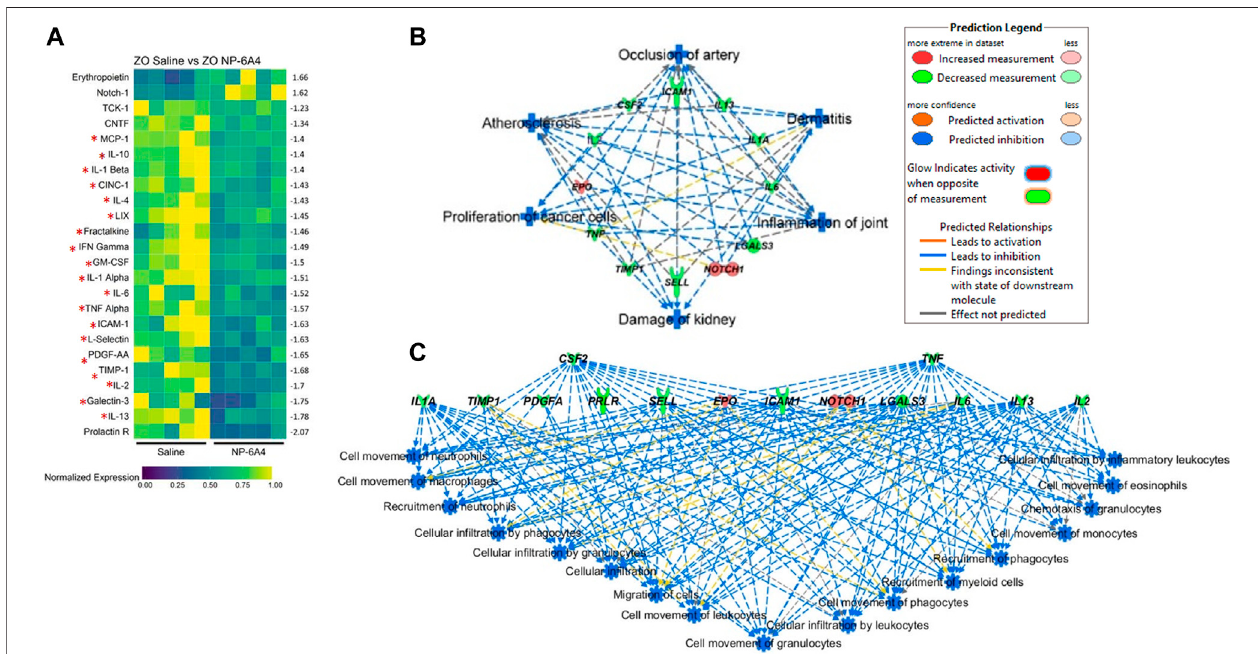
FIGURE5| NP-6A4suppressed alarge arrayofin fl ammatory and fi brotic cytokines implicated inboth cardiac pathologies and cytokine storm and simultaneously increasedexpressionofcardio-protectiveerythropoietin(EPO)andNotch1thatpromotemyocardialrepairinthehearttissuesofobeseandpre-diabeticZOrat. (A) Heat map shows agraphic representation of relative expression of 24differentially expressed intracardiac cytokines signi fi cantly different between saline and NP-6A4 treated ZO rat hearts. Individual cardiac samples are arranged along the x -axis and cytokines along the y -axis. 19 cardiac molecules implicated in cardiac pathologies ( Table 1 ) and suppressed by NP-6A4 are marked by red star. Fifteen cytokines that exhibited 1.5-fold differential expression in either direction were further selected for IPA analysis (see Supplementary Table S3 ). n (cid:1) 5 animals per group. Yellow indicates the highest expression for each cytokine (1.0), while dark blue indicates lower expression relative to the sample with the highest expression. Expression was normalized for each cytokine across all animals (across each row). Statistical signi fi cance was determined using Student ’ s t-test. p < 0.05 for all proteins. (B) Top scoring IPA-predicted diseases and functions networks resulting from the comparison of cytokineproteins( SupplementaryTableS3 )ofsalineandNP-6A4 treatedZOrathearts.Sixdiseasesandfunctionswerepredictedtobesuppressed(blueincolor)by NP-6A4 treatmentbasedon thiscytokinepro fi le.Additional details foreach individualnetworkinthisgroup areprovided in SupplementaryFigureS2 . (C) Immune cell speci fi c functions that are predicted to be suppressed in NP-6A4 treated ZO rat hearts. Green cytokines indicate downregulation in NP-6A4-treated compared with saline-treated ZO rat hearts. The blue connecting lines show a known relationship between the cytokine and the cellular process/function. This fi gure was generated using IPA ’ s built in feature for “ Diseases and Functions ” , and then selecting “ immune system related ” processes.